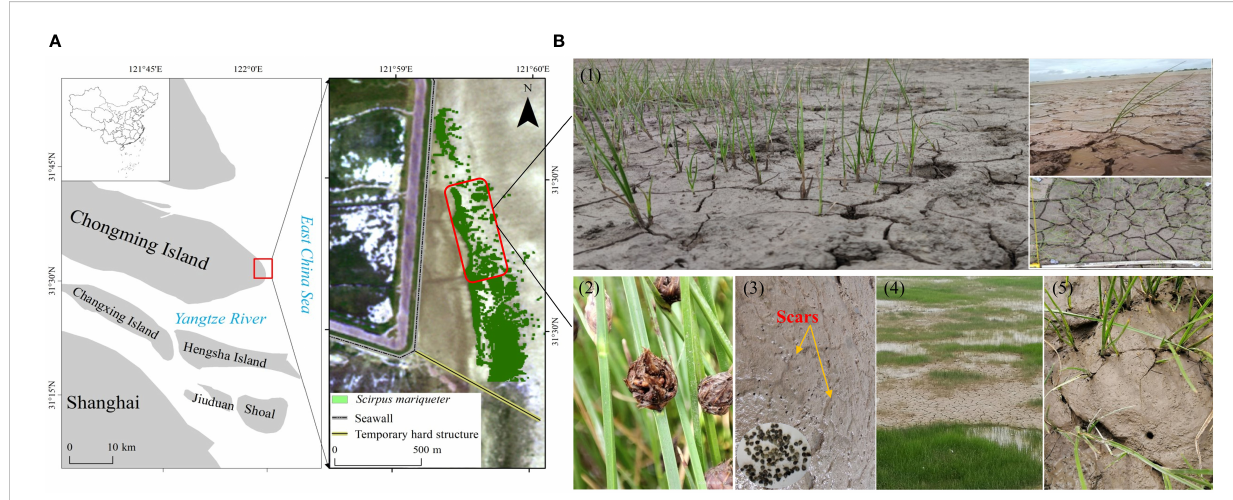
FIGURE 1 Study area and fi eld site. (A) Location of the Chongming Dongtan wetland and distribution of S. mariqueter . (B1) Extensive formation of mud cracks on mud surfaces at the saltmarsh edge. (B2) Mature seeds and seed retention on mud surfaces and cracks in August 2021. (B3) Healed scars of mud cracks as an indicator of previous wetting – drying cycles on bare mud fl ats and S. mariqueter seeds trapped in mud cracks. (B4, B5) Seedlings in mud cracks and